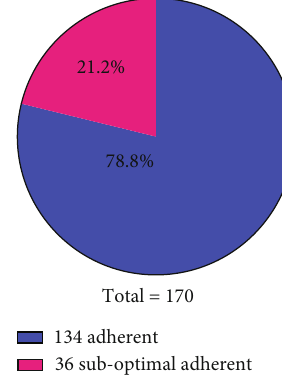
Figure 1: Postdischarge adherence of participants with LMWH for venous thromboprophylaxis after cesarean